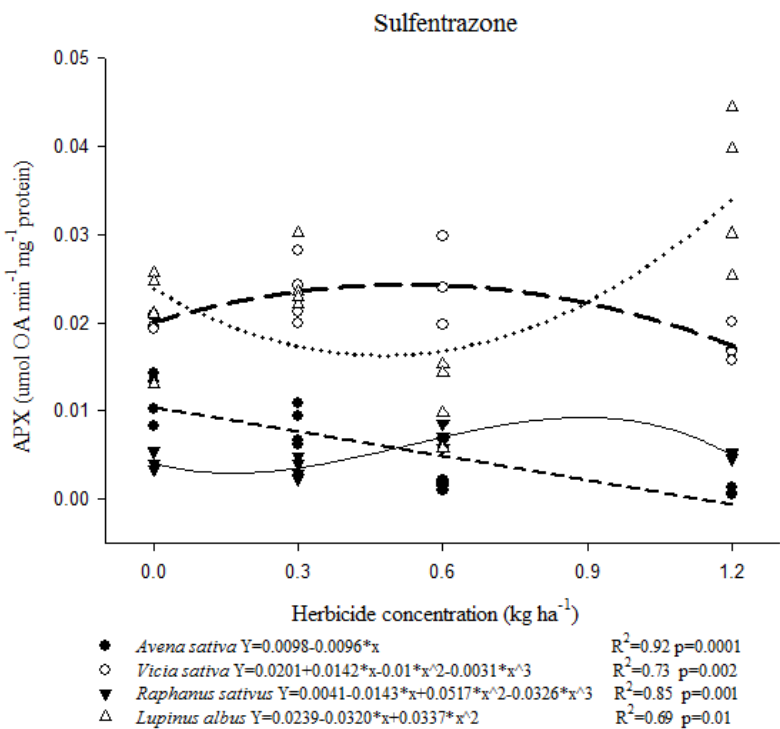
Figure 8 - Effect of sulfentrazone on Ascorbate peroxidase (APX) activity in different crop